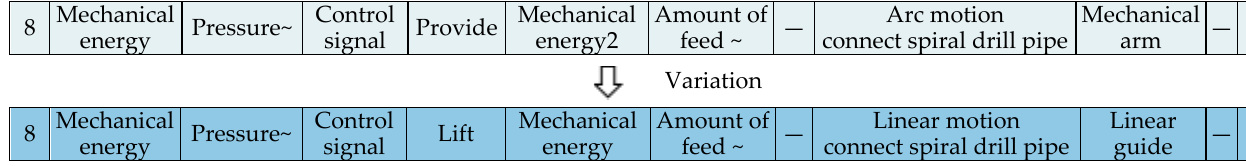
Figure 29. Product genetic variation of the mechanical arm of wood gripper.